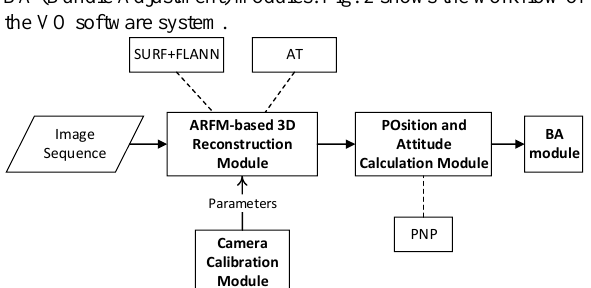
Fig. 2 The workflow of the ARFM-based VO software